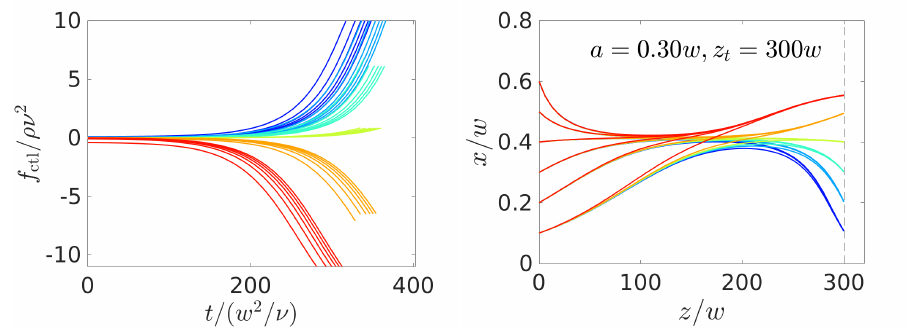
Figure 9. Optimal control-force protocols ( left column) and particle trajectories in the x - z plane ( right column) found for steering colloids with radii a / w = 0.2, 0.25, and 0.3 ( top , middle , and bottom row) to an axial target position z t = 300 w . The vertical dashed line indicates z t